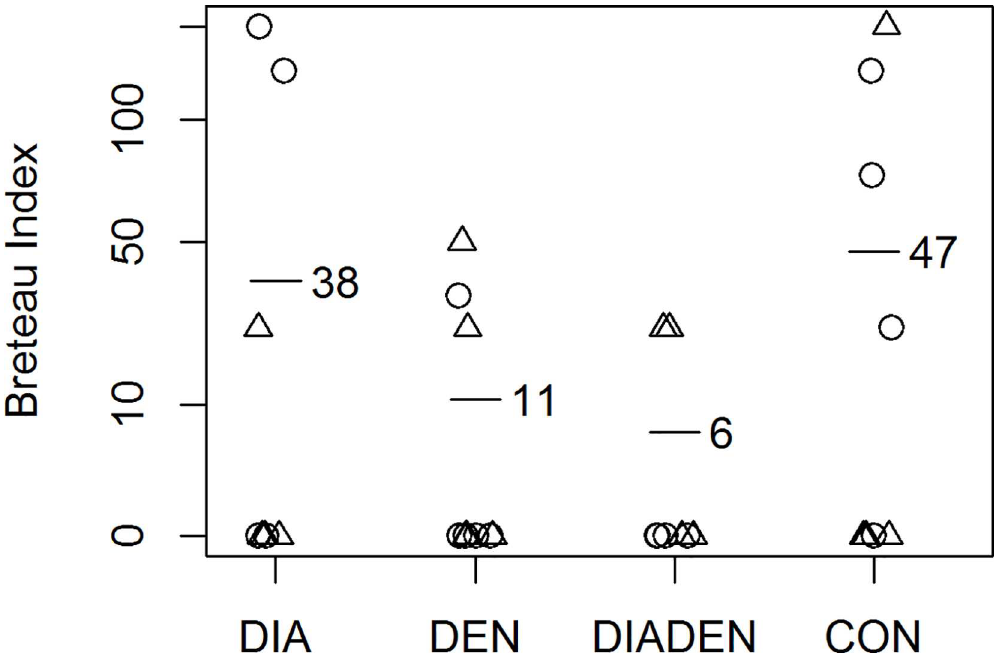
Fig 2. Effect of interventions on Breteau indices. Mean Breteau indices (horizontalbars with number) in rural primary schools in four arms receivingeither diarrhea(DIA), dengue(DEN), both (DIADEN), or no intervention (CON). Each plot symbol is one school (circles = Anapoima, triangles = La Mesa. The dengueinterventions reduced the mean Breteau Index by 78% (ratio 0.22, 95% confidence interval 0.06–0.84, p =